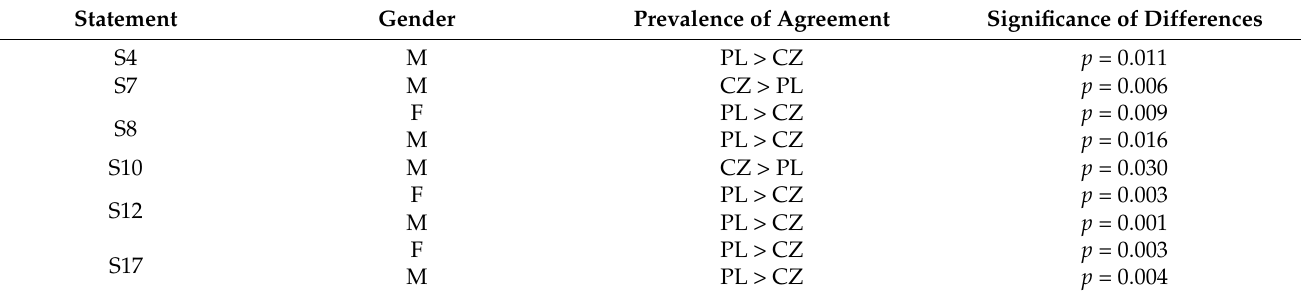
Table 6. Analysis of the prevalence of agreement with statements by nationality and